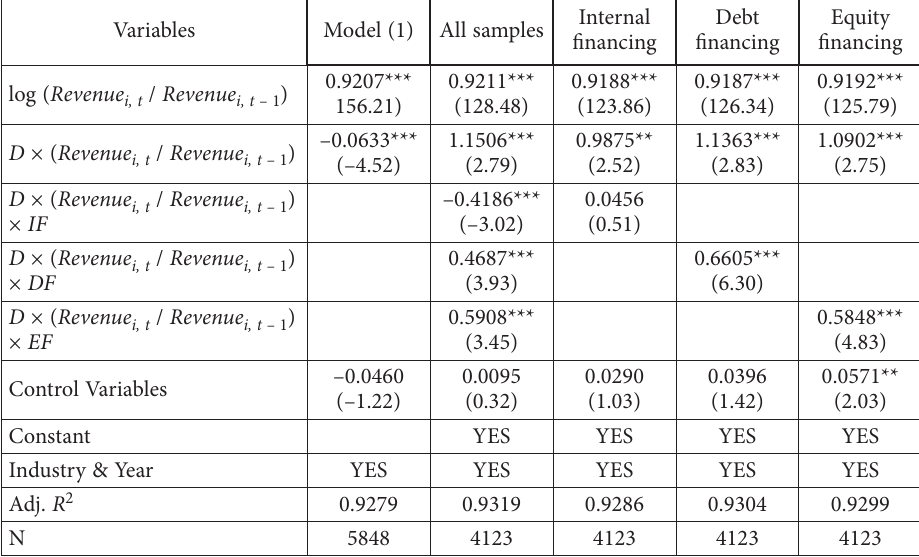
Table 7. Regression results of financing constraints on total cost